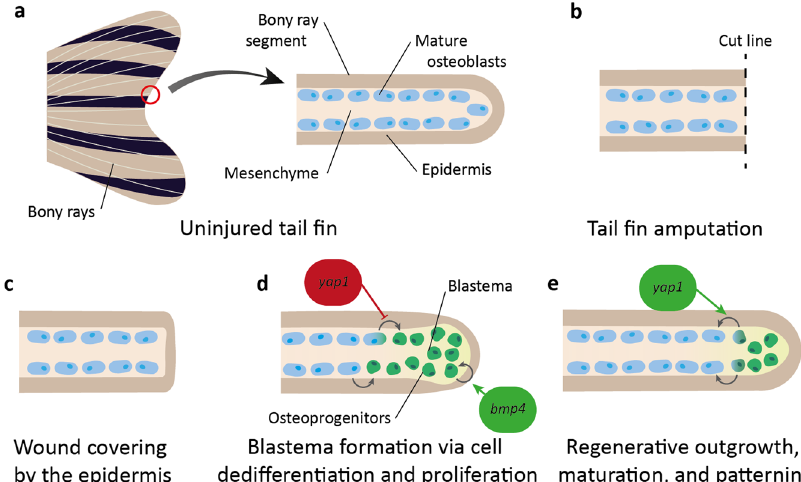
Fig. 5 Overview of zebra fi sh tail fi n regeneration (adult), focussing on osteoblast regeneration of bony rays. a The uninjured tail fi n of the adult zebra fi sh is formed of many bony rays, which each consist of epidermis surrounding mature osteoblasts (purple) in the mesenchyme. b Amputation of the tail fi n disrupts the bony ray segment. c In the initial stages of tail fi n regeneration the epidermis covers the wound. d Osteoblasts and other mature cells dedifferentiate and proliferate at the wound tip to form a blastema with osteoprogenitors (green). yap1 inhibits osteoblast dedifferentiation and bmp4 enhances blastema cell proliferation. e The bony ray segment extends through maturation of the progenitor cells back to their original cell type. yap1 promotes osteoprogenitor